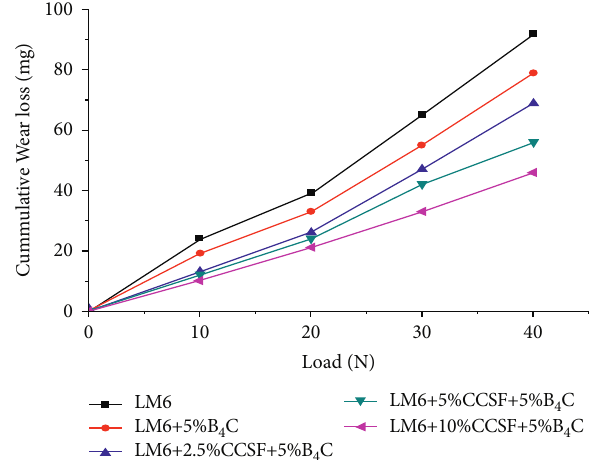
Figure 11: Cumulative wear losses with varying load conditions of LM6 Al alloy and hybrid composites.